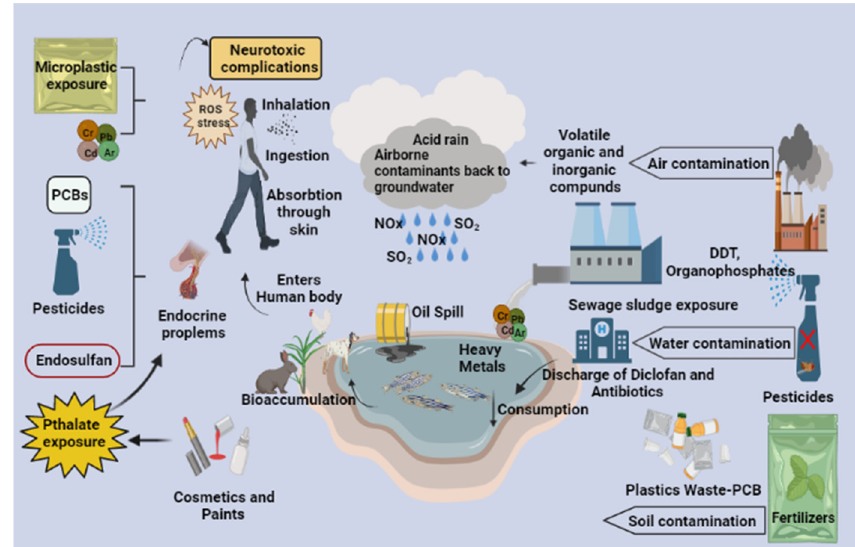
Figure 1. Influence of anthropogenic activities leads to the accumulation of pollutants in the envi- ronment. Waste disposed by factories and pharmacies containing mixed contaminants enters the food chain and bioaccumulates in higher organisms. These pollutants in living organisms alter sev- eral biological mechanisms and threaten normal